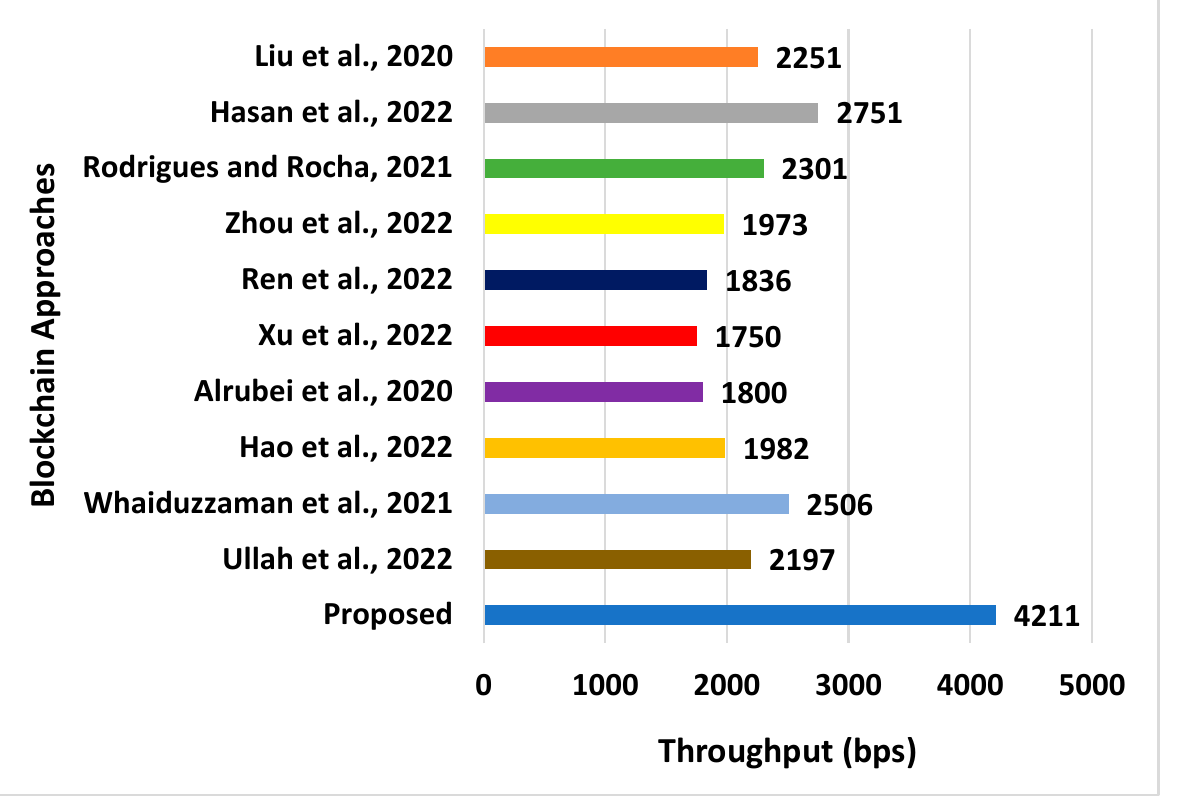
Figure 4. Analysis of throughput [39–48].